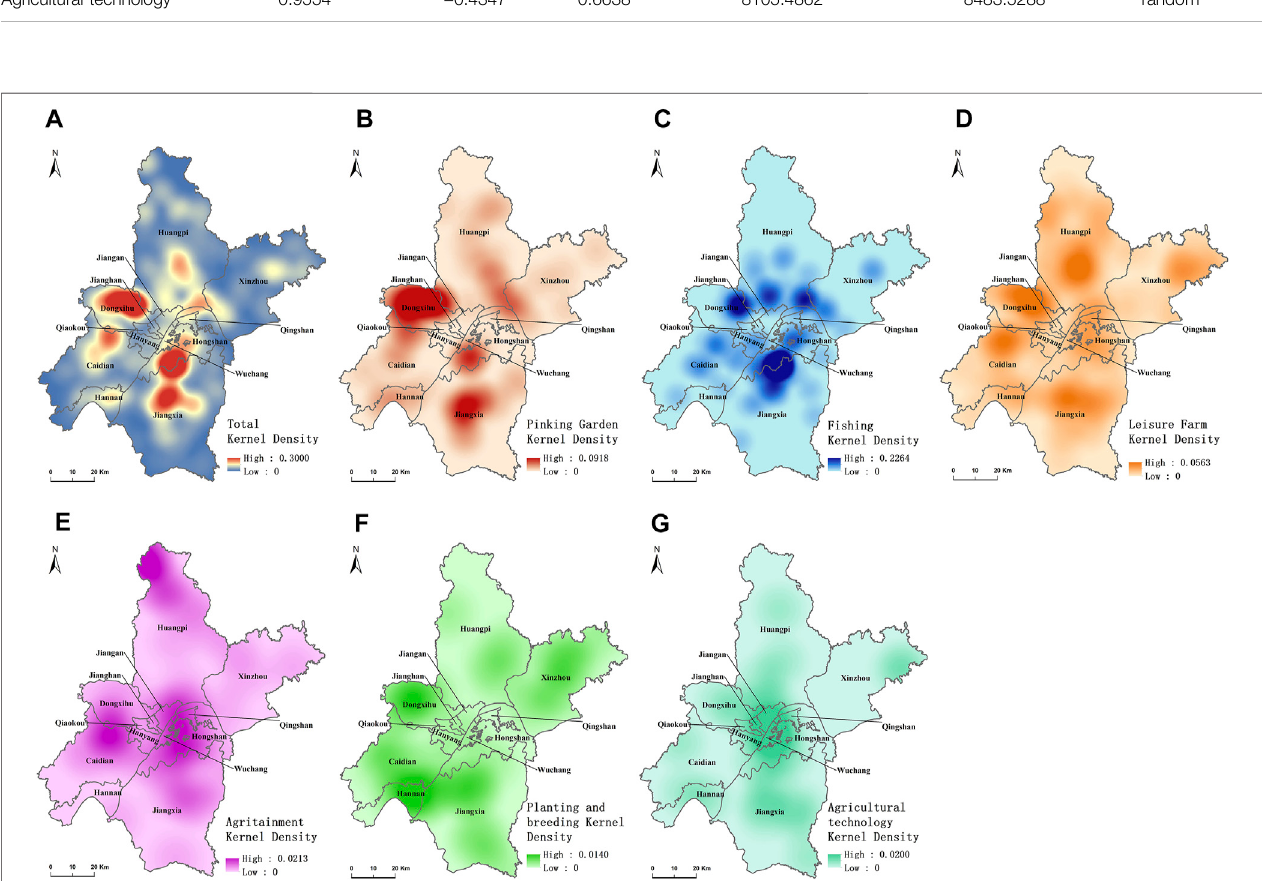
FIGURE 5 | The kernel density of leisure agriculture in Wuhan: (A) All types; (B) Picking Garden; (C) Fishing; (D) Leisure Farm; (E) Agritainment; (F) Planting and breeding; (G) Agricultural Technology.